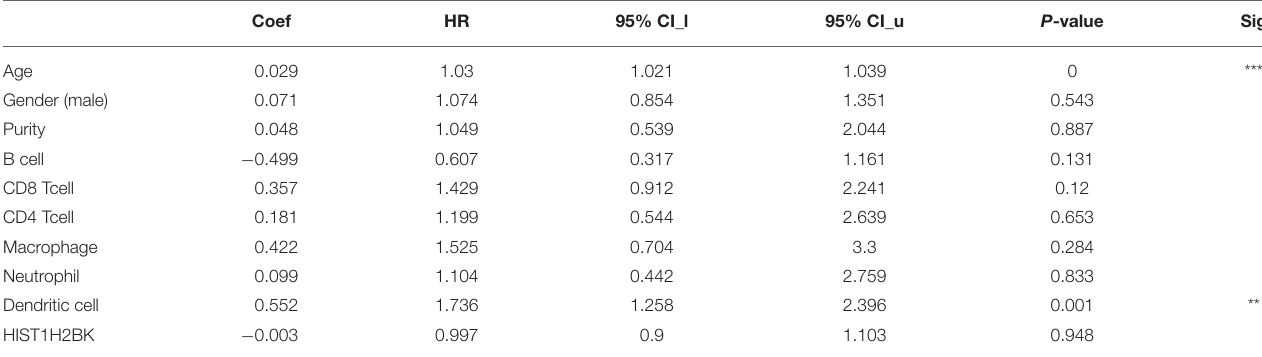
TABLE 4 | Multivariate analysis of the correlation of HIST1H2BK expression with immune infiltrates and OS in patients with GBM. Coef HR 95%